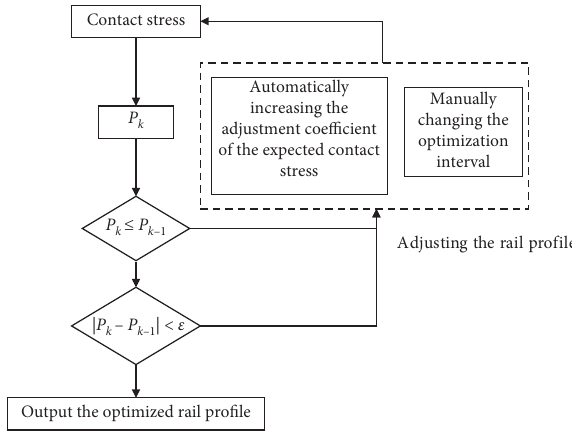
Figure 8: Flowchart of optimal convergence condition of the rail profile.